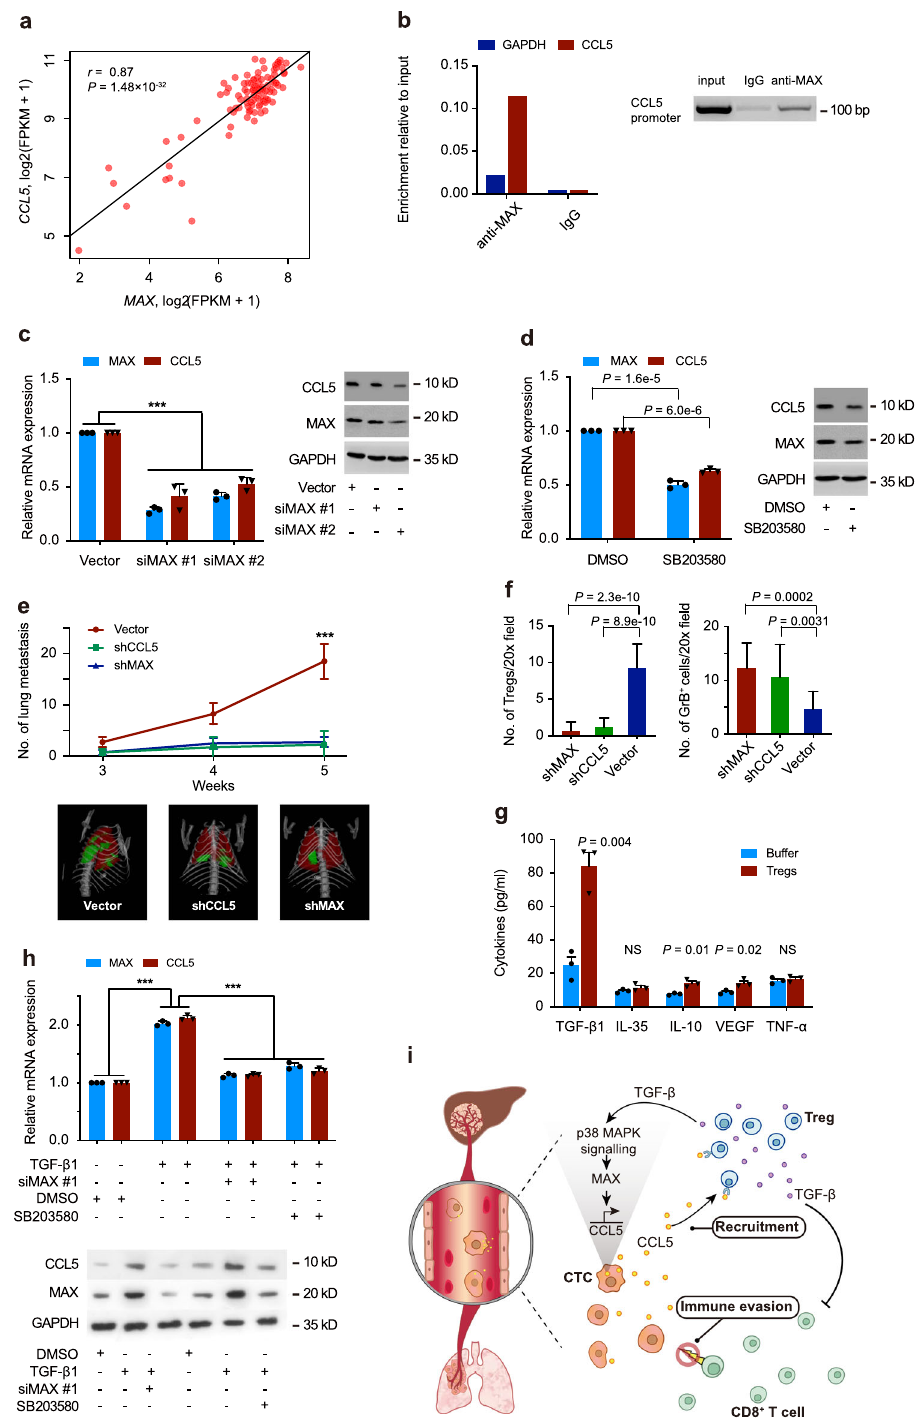
system and China staging system for liver cancer (2017 edition) 1 , and tumor differentiation was de fi ned according to the Edmondson grading system. HCC patient demographics are provided in Supplementary Data 1 and 5. Patients with histories of other solid tumors were